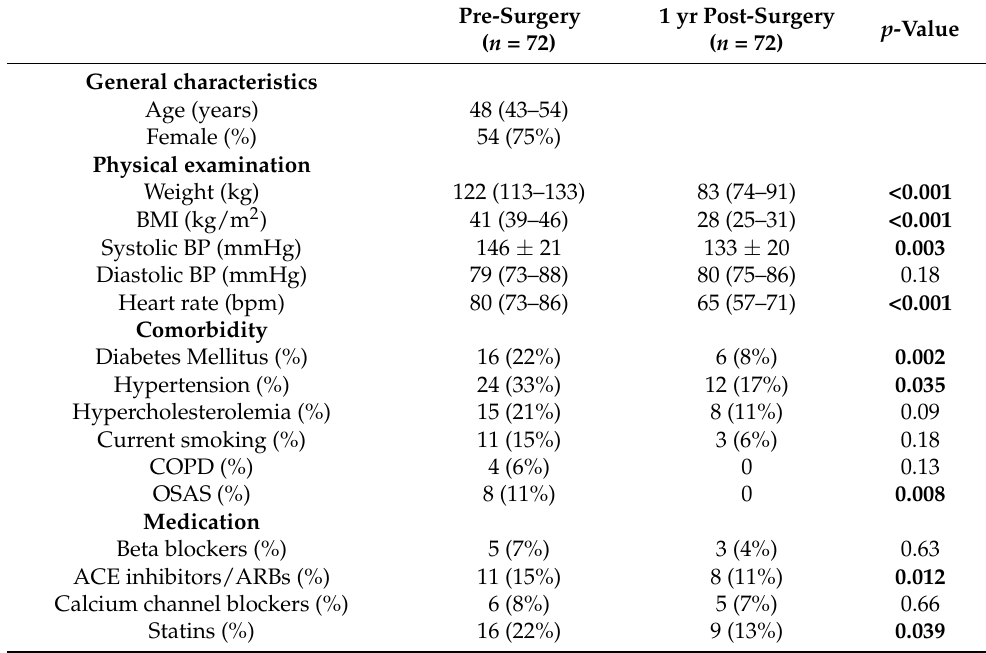
Table 1. Clinical characteristics of the study population. Changes in obesity patients from pre- to post-bariatric